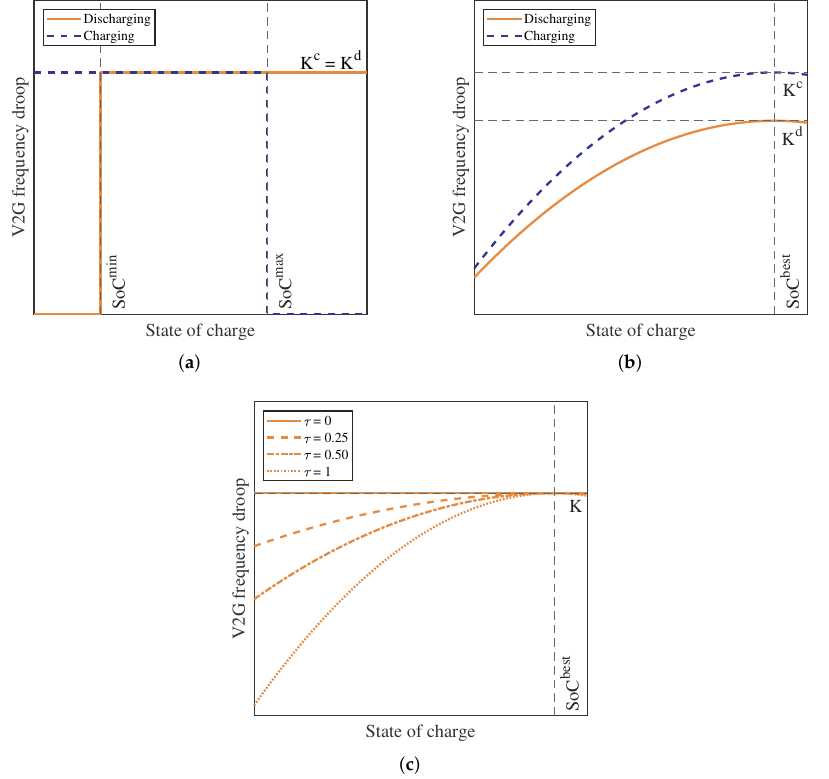
Figure 5. V2G frequency droop as a function of the SoC for the charging and discharging cases for the BoCo approach ( a ). V2G frequency droop as a function of the SoC for the charging and discharging cases for the LoDeCo approach ( b ). V2G frequency droop as a function of the SoC for the LoDeCo for different τ values ( c